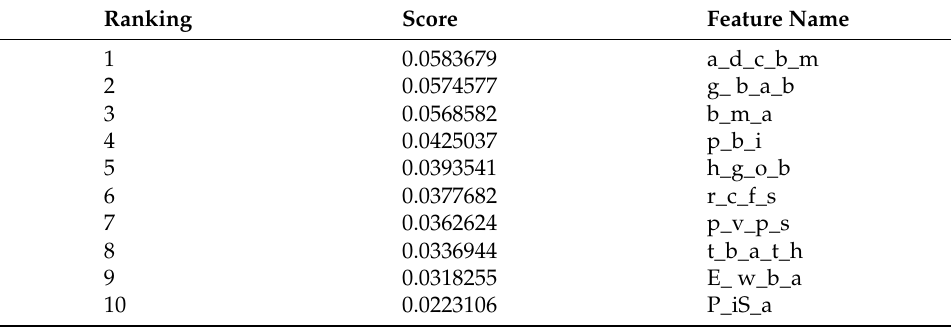
Table 4. Ranking with filter